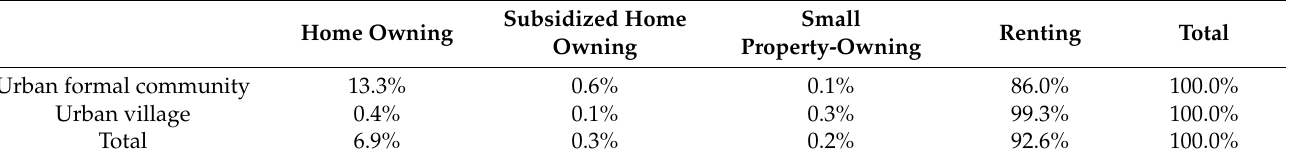
Table 1. Rural migrants’ housing choices in Beijing,